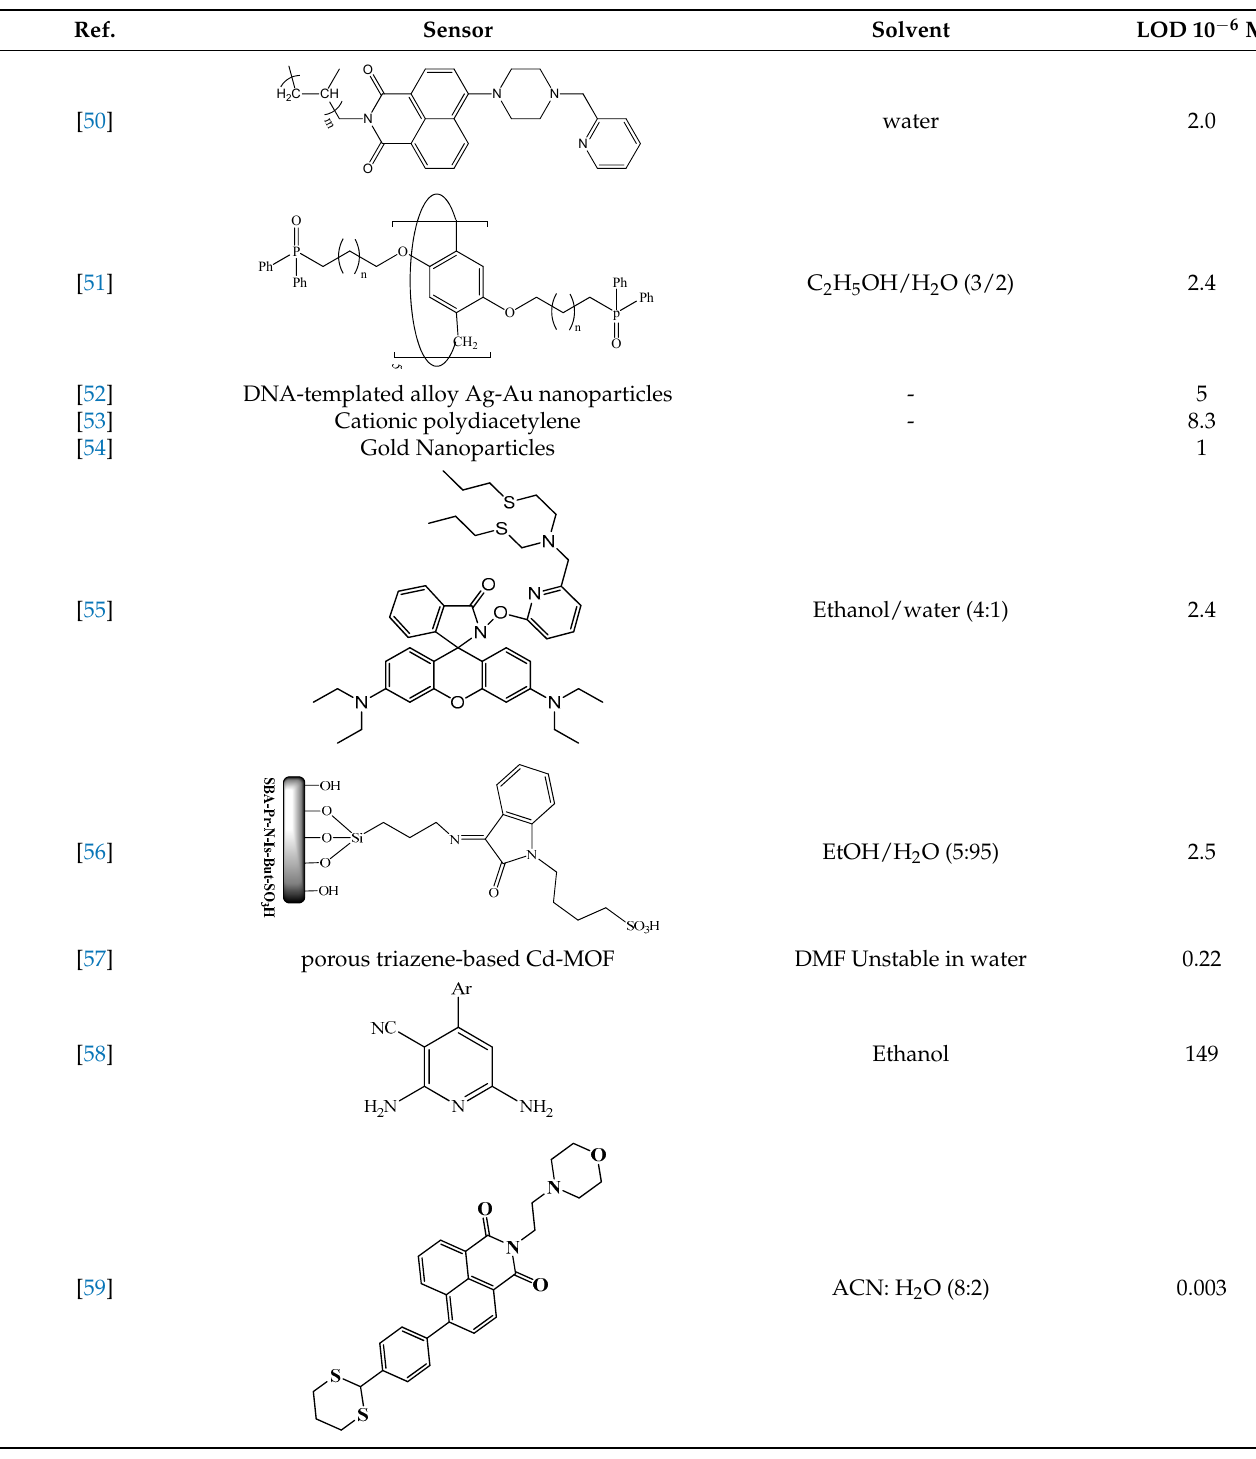
Table 3. Comparsion of some fluorescent chemosensors for Hg 2+ detection. Ref.